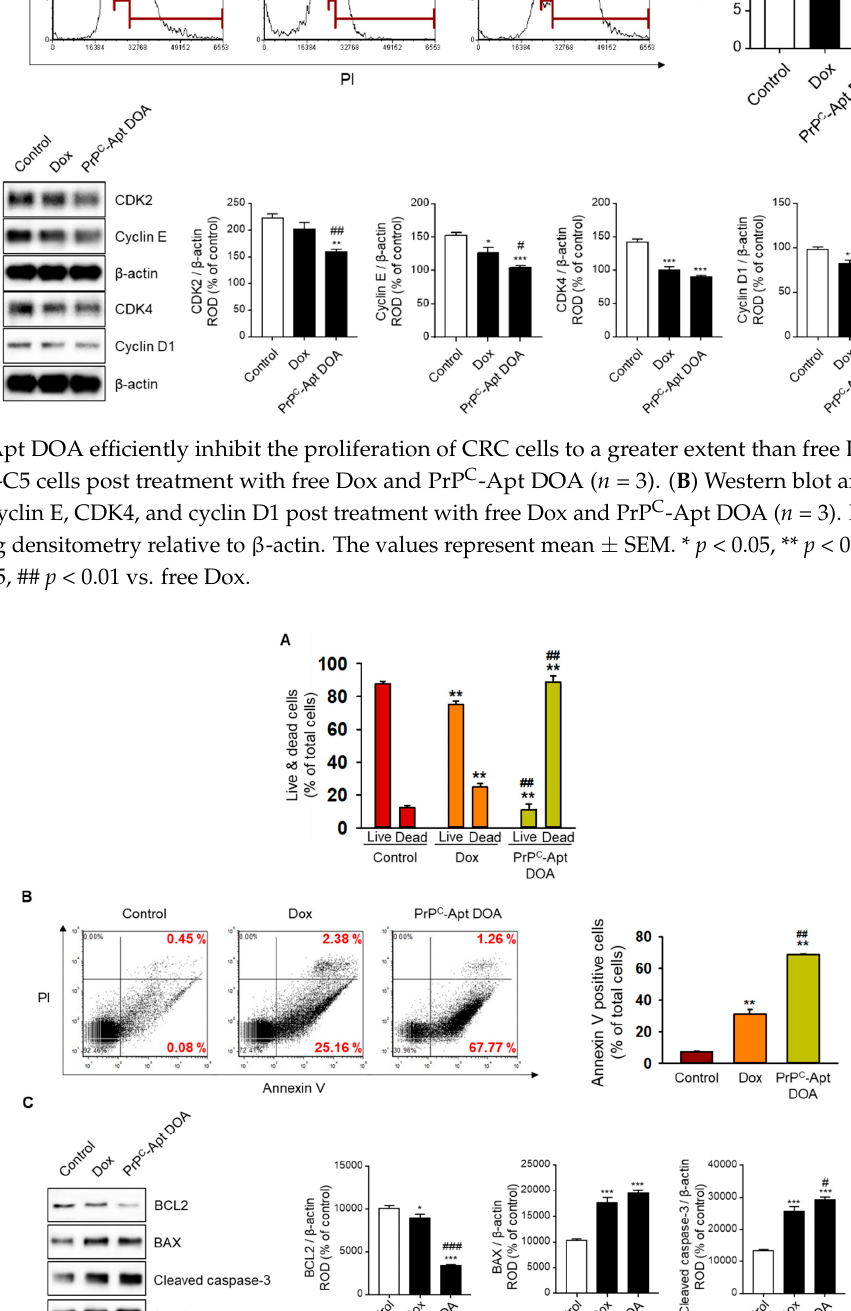
CRC cells. SNU-C5 cells were cultured in ultra-low attachment six-well plates for 14 d in the presence of free Dox or PrP C -Apt DOA. As shown in Figure 8A, while free Dox also inhibited sphere formation of CRC cells, PrP C -Apt DOA efficiently inhibited sphere for- mation in SNU-C5 cells, as compared to free DOX. The diameters of the spheres were significantly reduced in PrP C -Apt-DOA-treated SNU-C5 cells (Figure 8B). These results suggest that PrP C -Apt DOA not only increased the apoptosis of CRC cells, but also inhib- ited the cancer stem cell properties of CRC cells.